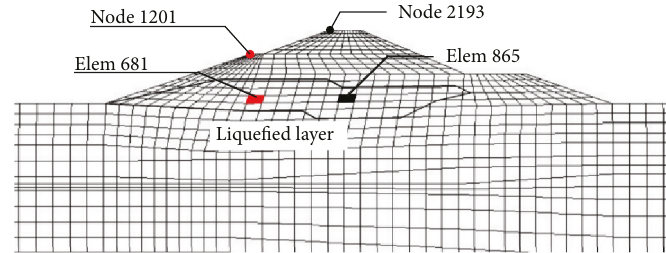
Figure 18: Location of focused nodes and elements.